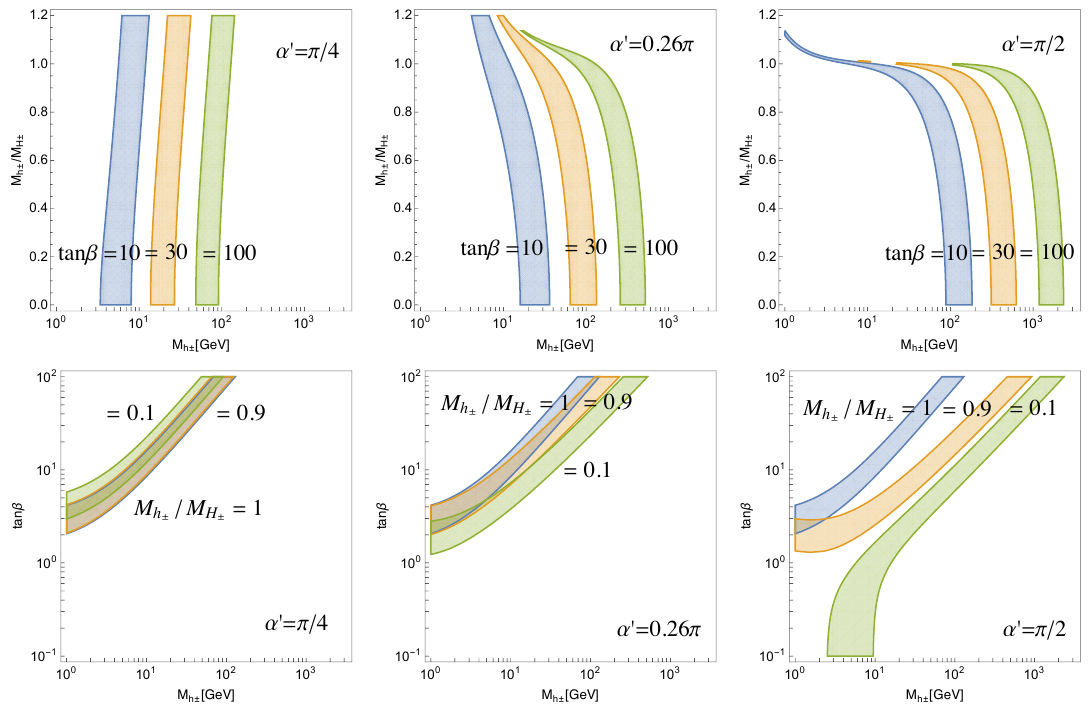
Figure 2 . Upper row: parameter space in the ( M h ; M h =M H ) plane for tan (cid:12) = 10 (blue), (cid:6) (cid:6) (cid:6) 30 (orange) and 100 (green), as preferred by the muon g (cid:0) 2 anomaly at 2 (cid:27) level. Lower row: parameter space in the ( M h ; tan (cid:12) ) plane for the mass ratio M h =M H = 1 (blue), 0 : 9 (orange) (cid:6) (cid:6) (cid:6) and 1 (green). The left, middle, right plots are the cases with (cid:11) 0 = (cid:25)= 4 ; 0 : 26 (cid:25); (cid:25)= 2, respectively. be made positive by choosing an appropriate mixing angle (cid:11) 0 . The (cid:13)avor-changing scalar interactions also respect the muon number conservation, so that lepton (cid:13)avor violation is forbidden in this